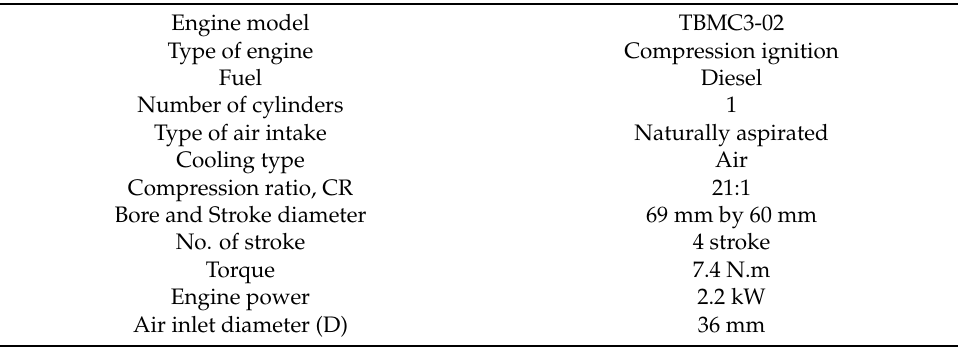
Table 6. Test engine TBMC3-02 technical